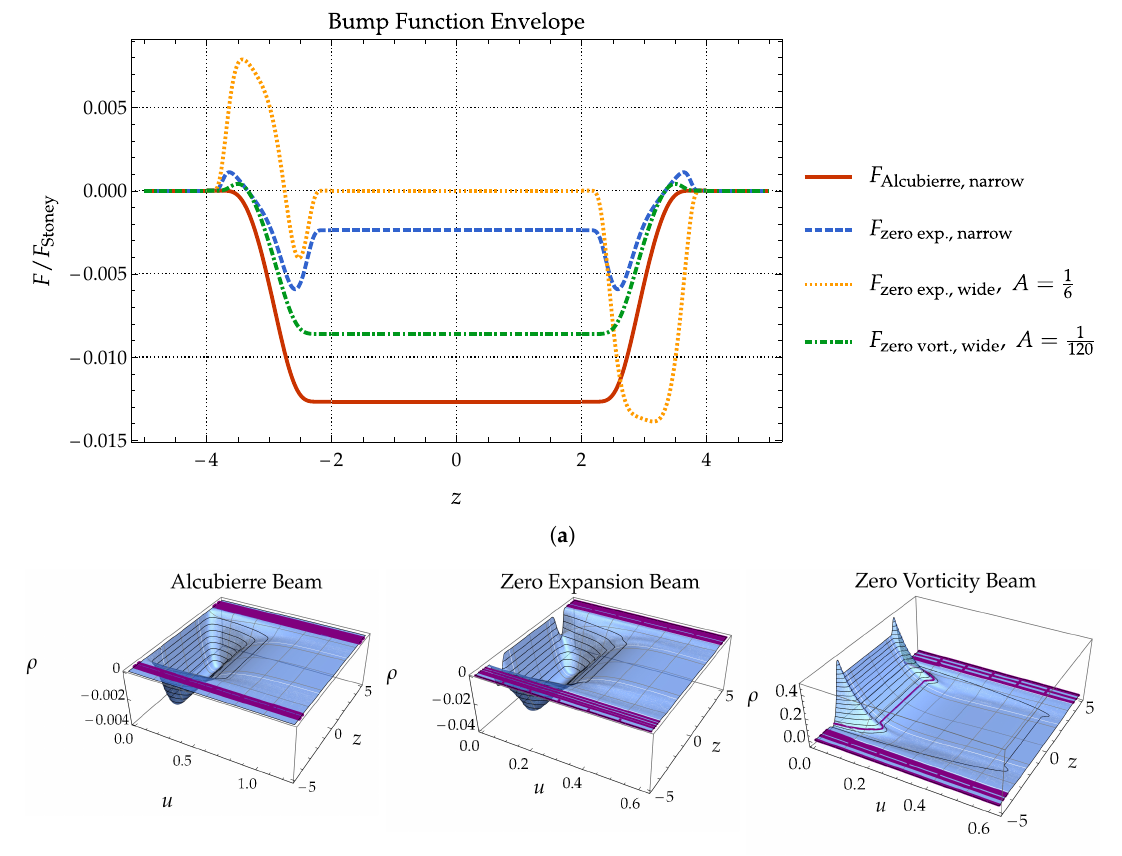
Figure 4. ( a ) Forces F and ( b ) energy densities ρ for beam profiles with smooth bump functions as described by Equation (190); the parameters in these pictures are t = − 1, a = 2, b = 4, A = 0.5, B = C = 1.0 and D = 1.0. The purple lines and bands in the density plots indicate locations where the energy density is zero or indistinguishable from